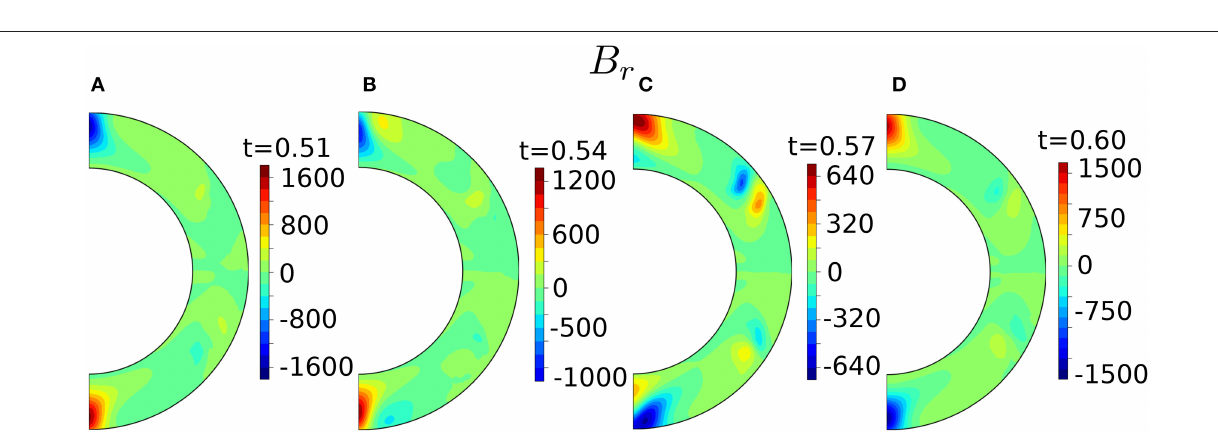
field of positive polarity in the northern hemisphere